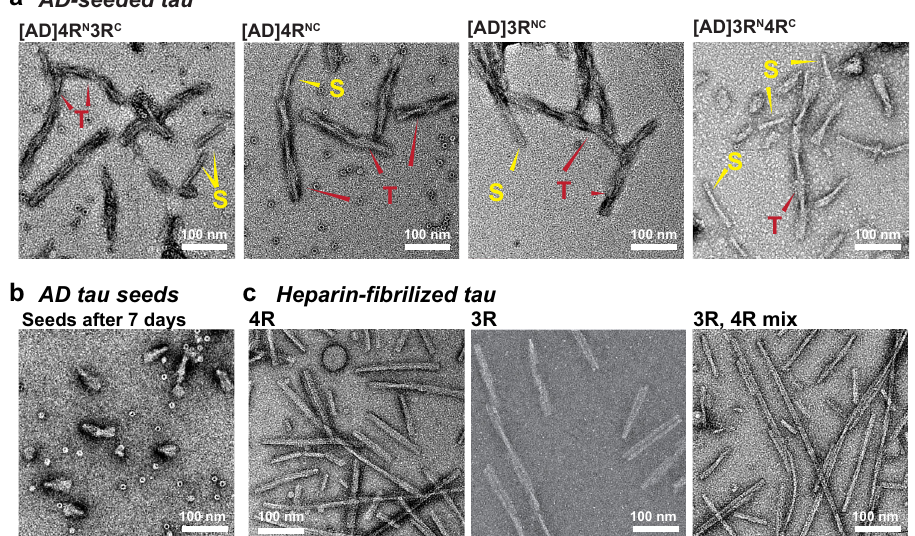
Fig. 2 Ultrastructural morphology of AD-tau seeded tau fi brils is distinct from that of heparin- fi brillized tau. a TEM images of AD-tau seeded fi brils containing a 1:1 mixture of 15 N-labeled 4R tau and 13 C-labeled 3R tau, 4R-only tau, 3R-only tau, and a 1:1 mixture of 15 N-labeled 3R tau and 13 C-labeled 4R tau. All samples show predominantly twisted (T) fi brils whose widths alternate between ~10 nm and ~25 nm, similar to the paired helical fi laments of AD tau. In addition, a minority of straight (S) fi brils are observed, which are similar to the straight fi laments of AD tau. b AD tau seeds after 7 days of incubation without added recombinant monomers. The seeds are fi vefold shorter than the ampli fi ed tau fi brils. No long fi brils are observed. c Heparin- assembled recombinant tau fi brils. These fi brils are nearly exclusively straight, and are longer and more uniform than the straight fi laments in AD-tau seeded fi laments. At least fi ve different images from different regions of each grid were obtained for each sample. A side-by-side comparison of these fi brils can be found in Supplementary Fig.